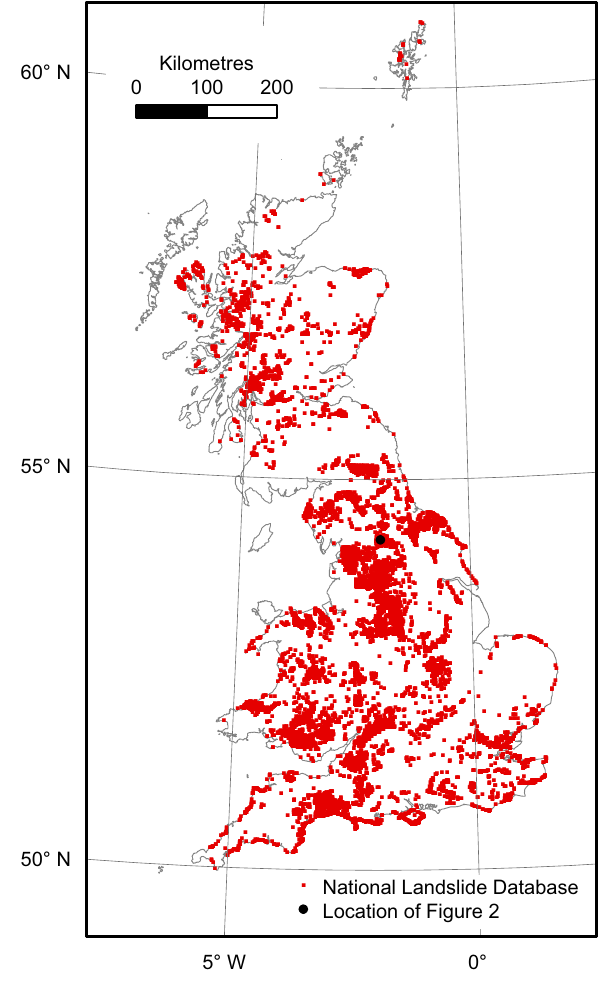
Figure 1. UK Map showing the distribution of landslide points in the NLD which have undergone quality assurance control at the British Geological Survey. Black circle shows the location of Fig.